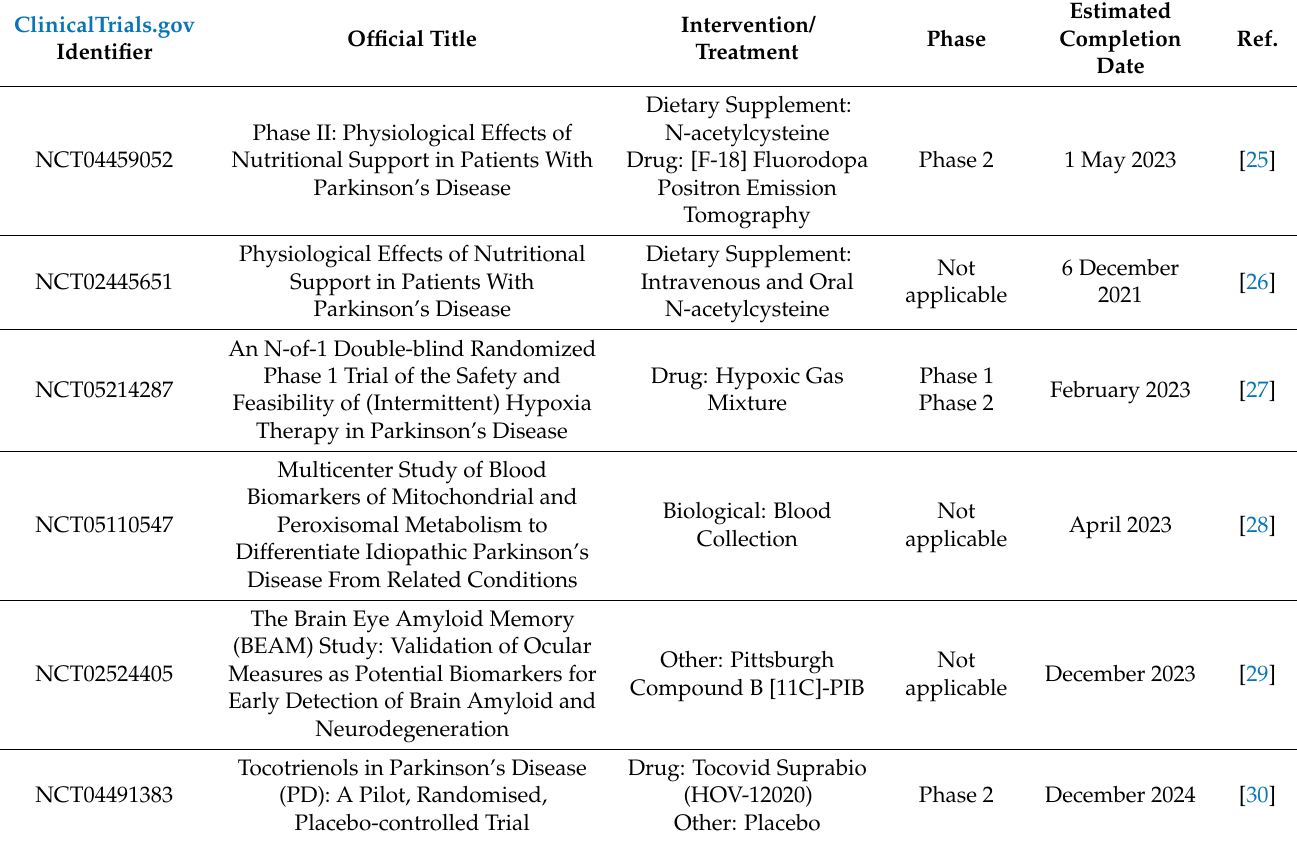
Table 1. Summary of active clinical trials investigating Parkinson’s disease in relation to oxidative stress. The studies have been retrieved from clinicaltrials.gov with search keywords “Condition or disease = Parkinson disease” and “Other terms = oxidative stress” and selecting the items with the status “Recruiting” and “Active, not